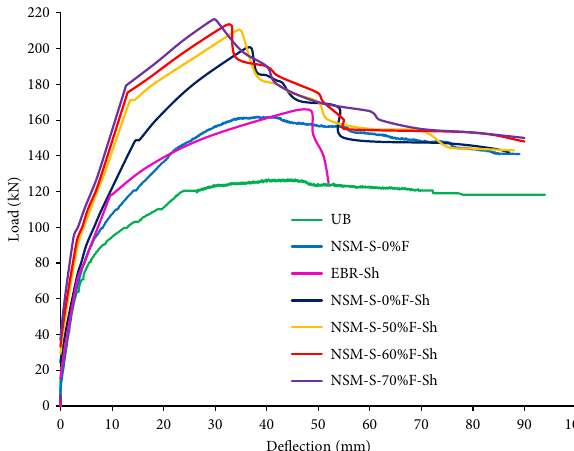
Figure 5. Load-deflection curves of the